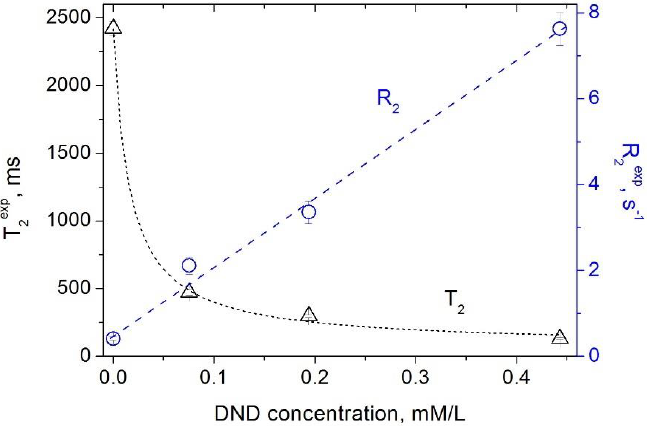
Figure 1. Dependence of the spin – lattice relaxation rate R 1 (circles) [16] and the spin – lattice relaxa-